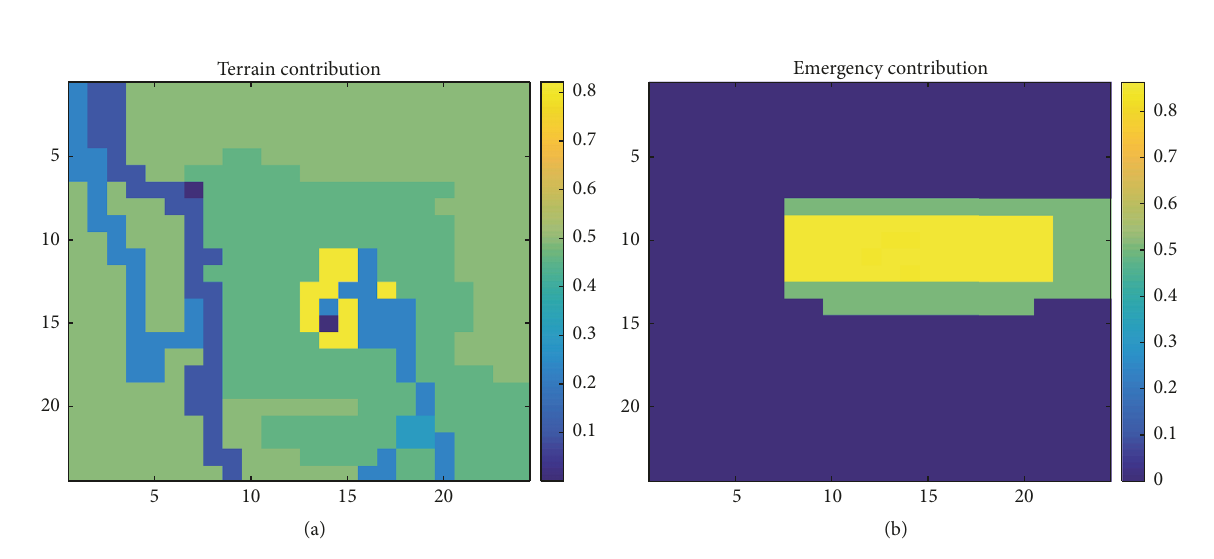
Figure 3: La Palma terrain (a) and emergency (b) maps.